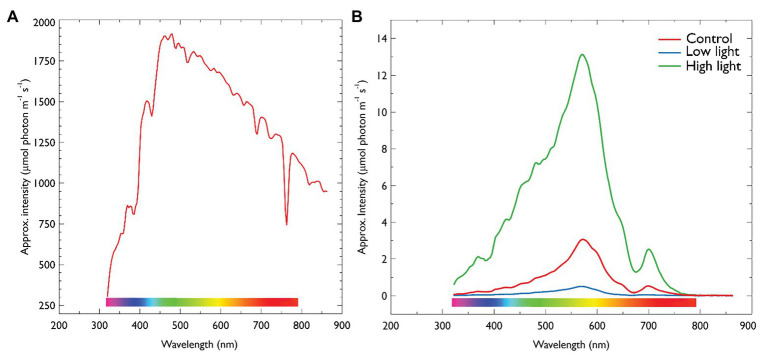

(A) Irradiance on ice-surface collected at midday. (B) Midday under-ice irradiance of each treatment described in Table 1. Irradiance was collected using a RAMSES radiometer (TriOS optical systems, Germany). Values are approximate intensities in μmol photons m−2 s−1. For under-ice measurements, the radiometer was attached to an articulating arm and inserting through an adjacent ice hole and maneuvered into center of each treatment. Control = 5 μmol photons m−2 s−1, 10 cm snow; Low light = 0.5 μmol photons m−2 s−1, 30 cm snow cover; High light = 13 μmol photons m−2 s−1, no snow.